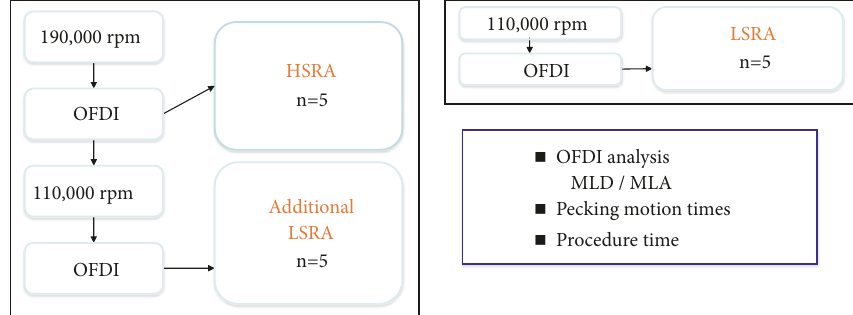
Figure 2: Study Flowchart of In-Vitro Calcified Model. OFDI= optical frequency domain imaging; HSRA= high-speed rotational atherectomy; LSRA= low-speed rotational atherectomy; MLD= minimum lumen diameter; MLA= minimum lumen area.